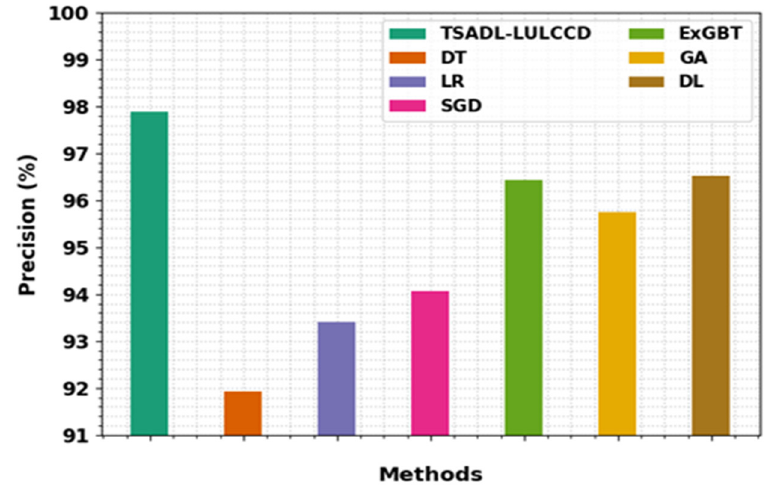
Figure 16. Prec n analysis of TSADL-LULCCD approach with other Figure 16. 𝑃𝑟𝑒𝑐 (cid:3041) analysis of TSADL-LULCCD approach with other approaches.